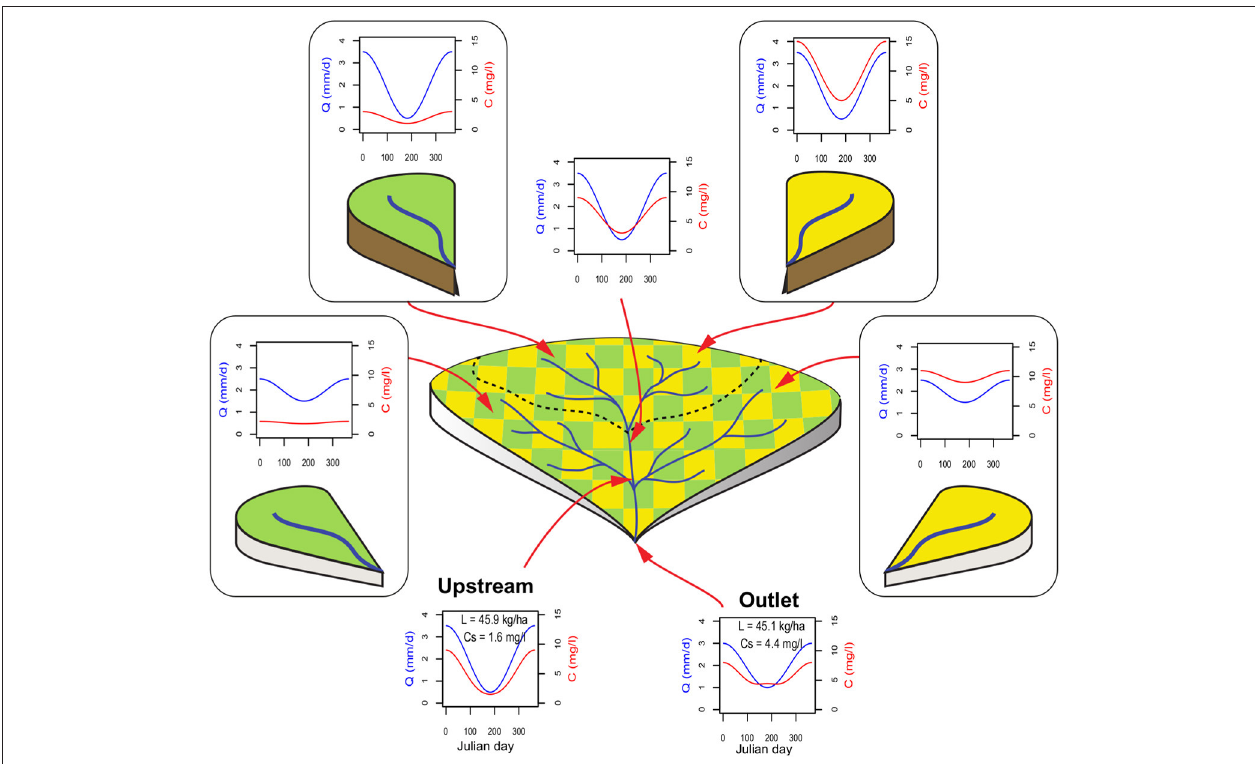
FIGURE 1 | Conceptual illustration of the landscape unit distribution (LUD) framework for reference scenario S0. Synthetic discharge (Q) and concentration (C) time series are shown for four different landscape units and the overall catchment, which is a product of signal propagation through a virtual river network. Landscape units are defined by their ecosystem properties, represented by the subsurface color and by the intensity of nutrient loading, represented by the surface